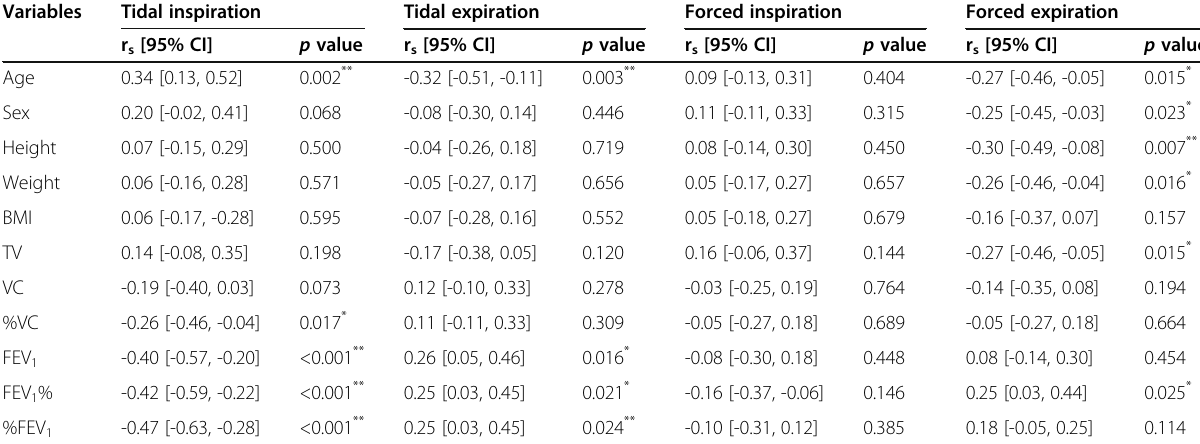
Table 2 Correlation between lung motion velocity in the right lung and demographic data